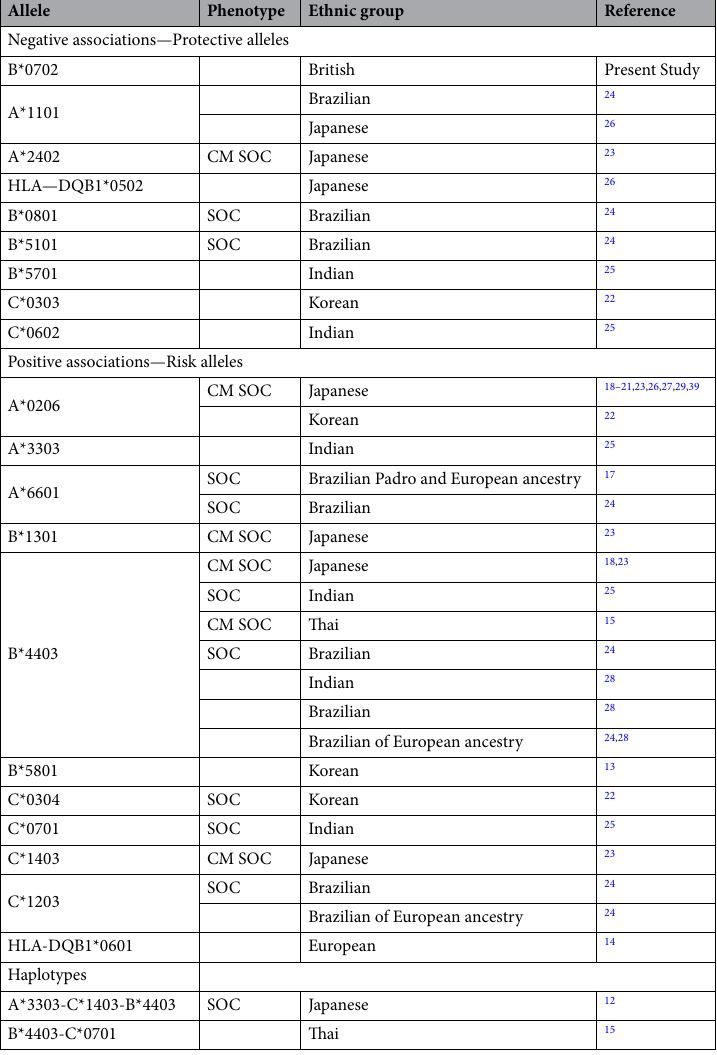
Table 4. Summary of HLA alleles associated with SJS/TEN with ocular complications. CM Cold medicine, SOC severe ocular